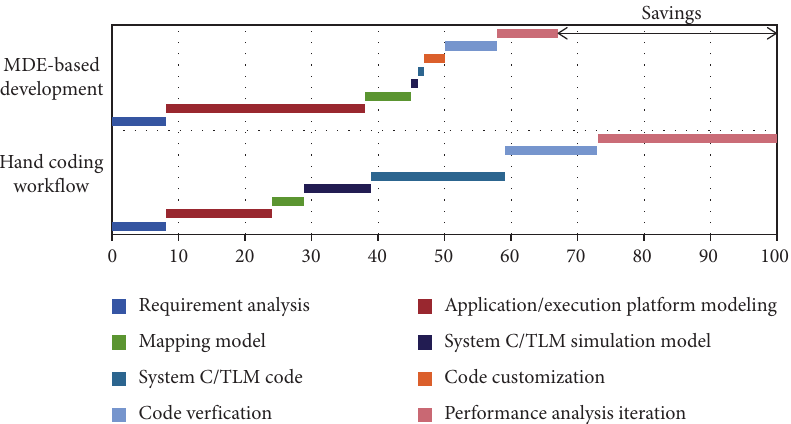
Figure 26: Classical hand coding workflow compared to MDE-based development process for DRSoCs